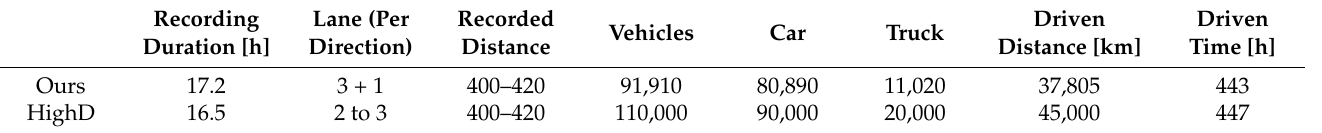
Table 1. Data comparison between China and Germany.